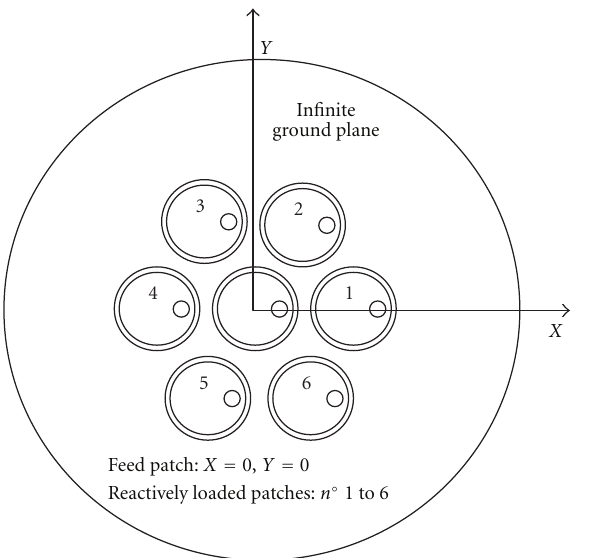
Figure 1: Planar ESPAR Array to be designed. Six reactively loaded patches over a infinite ground plane.